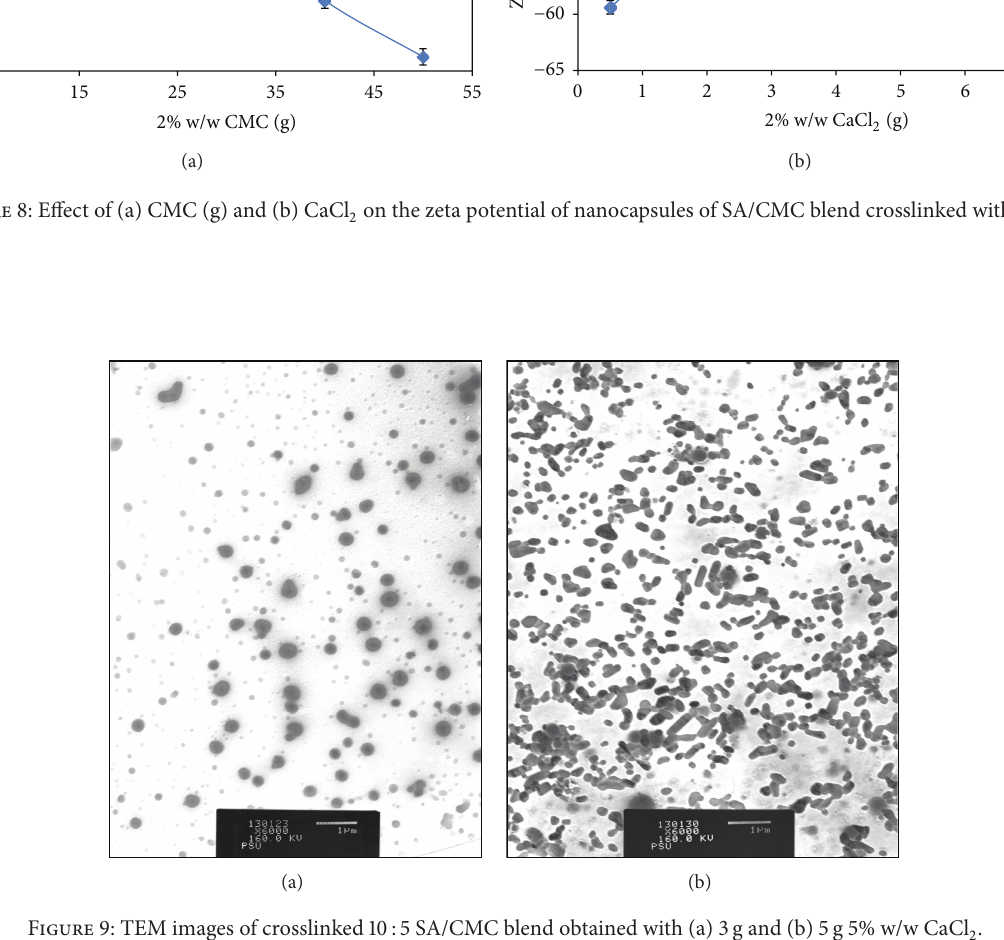
Figure 9: TEM images of crosslinked 10:5 SA/CMC blend obtained with (a) 3g and (b) 5g 5% w/w CaCl 2